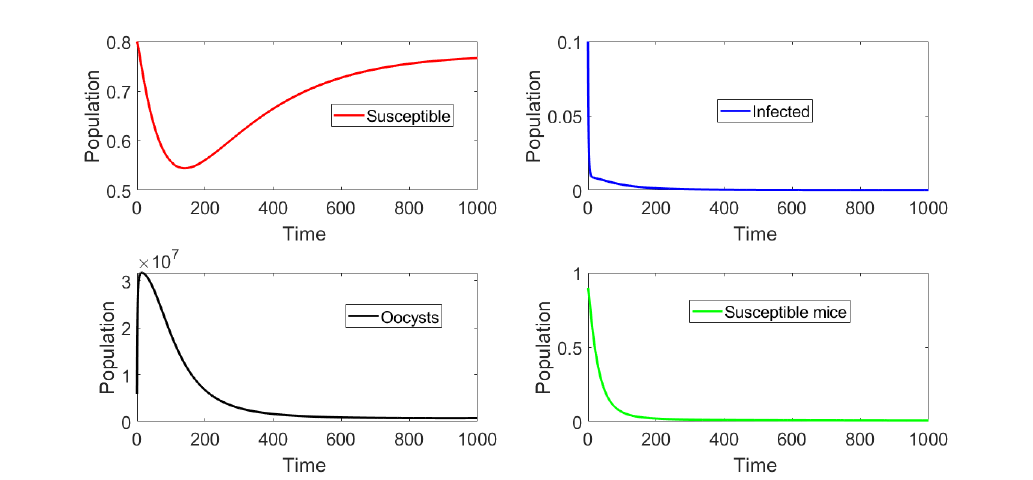
Figure 4. Dynamics of the different classes when R 0 = 1.04 and the initial subpopulations are distant from the endemic equilibrium E ∗ . Note that the oocyst and infected cat populations never become 0 extinct, as R 0 > 1.